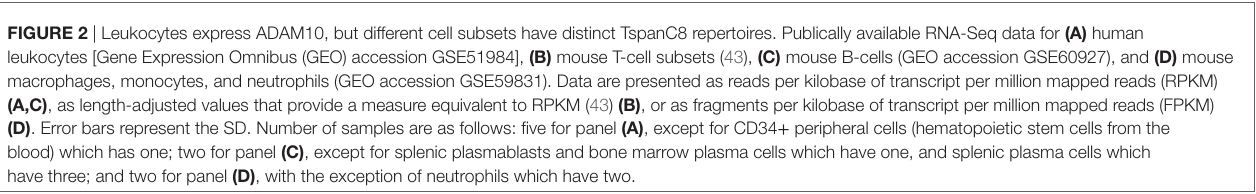
FigURe 2 | Leukocytes express ADAM10, but different cell subsets have distinct TspanC8 repertoires. Publically available RNA-Seq data for (A) human leukocytes [Gene Expression Omnibus (GEO) accession GSE51984], (B) mouse T-cell subsets (43), (C) mouse B-cells (GEO accession GSE60927), and (D) mouse macrophages, monocytes, and neutrophils (GEO accession GSE59831). Data are presented as reads per kilobase of transcript per million mapped reads (RPKM) (A,C) , as length-adjusted values that provide a measure equivalent to RPKM (43) (B) , or as fragments per kilobase of transcript per million mapped reads (FPKM) (D) . Error bars represent the SD. Number of samples are as follows: five for panel (A) , except for CD34 + peripheral cells (hematopoietic stem cells from the blood) which has one; two for panel (C) , except for splenic plasmablasts and bone marrow plasma cells which have one, and splenic plasma cells which have three; and two for panel (D) , with the exception of neutrophils which have